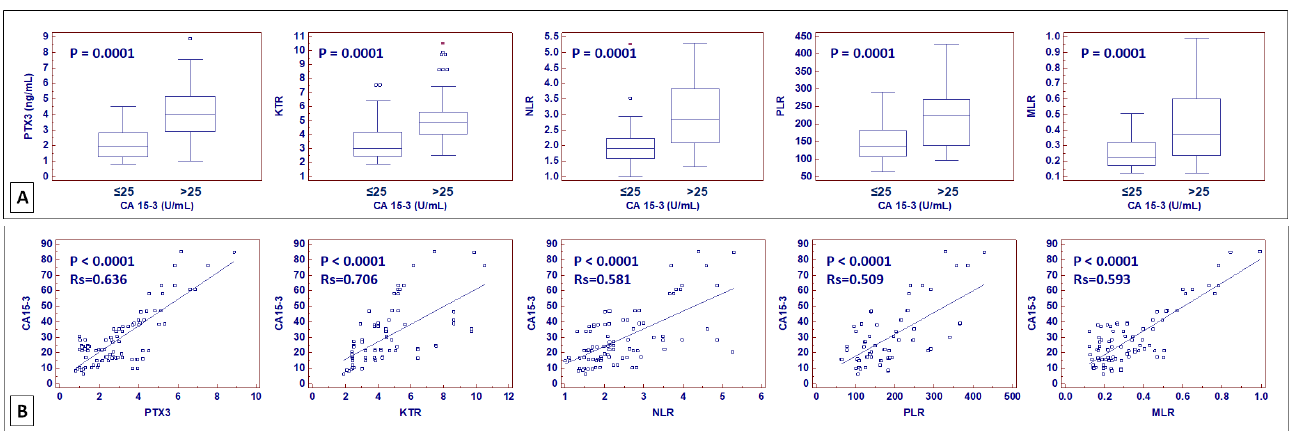
Figure 11. Immunohistochemical staining of CD8, CD4, and PD-L1 in MUC1 H ccRCC compared with MUC1 L tumor.